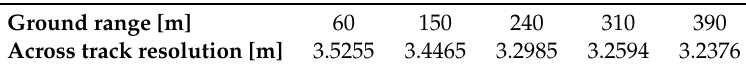
Table 15. Across track resolutions for chosen ground